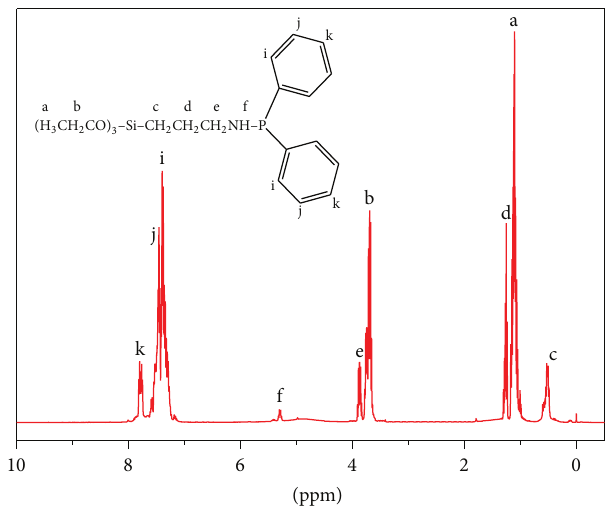
Figure 2: 1 H-NMR spectrum of DPTP.